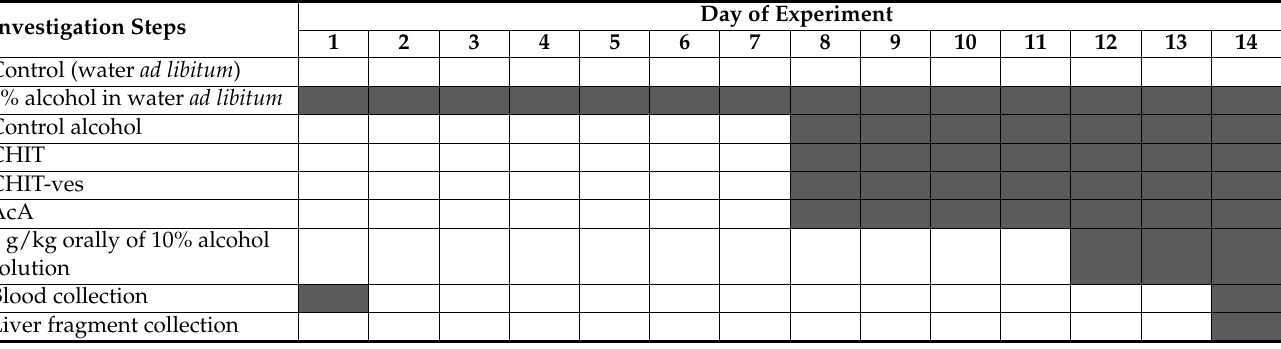
Table 1. Experimental protocol to evaluate the effects of chitosan vesicles in mice with alcohol-induced liver